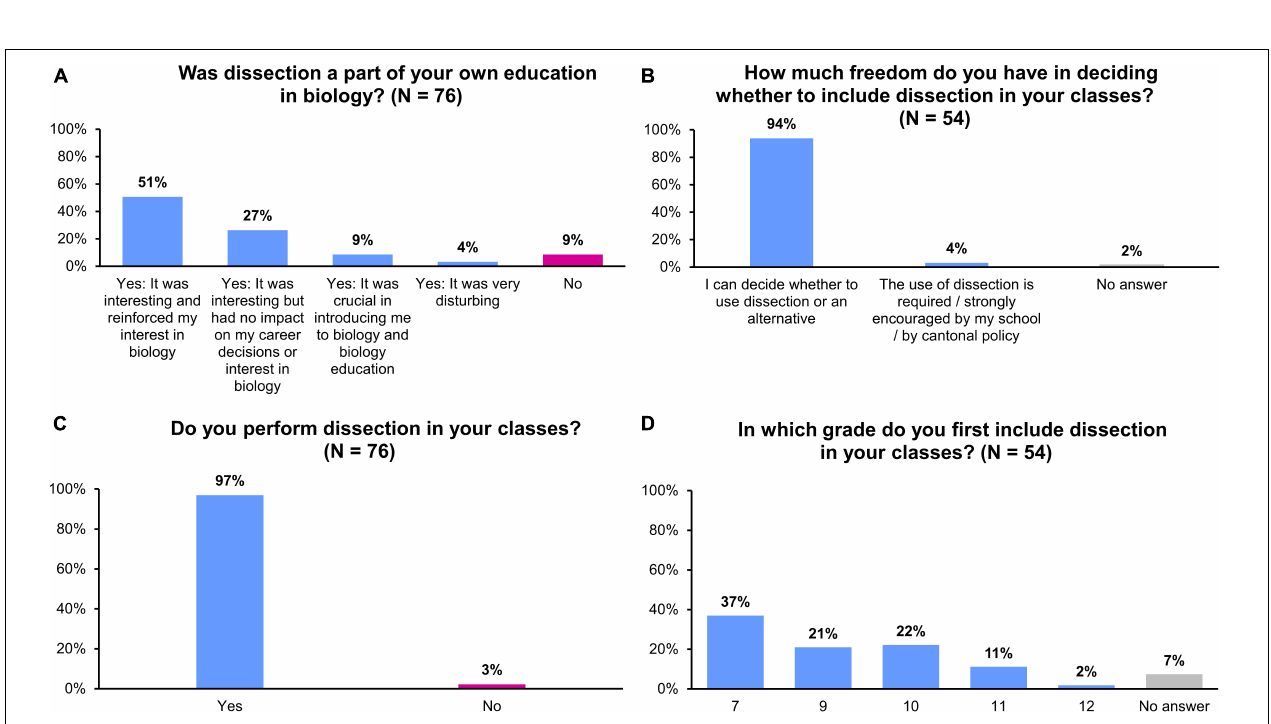
FIGURE 2 | (A) Experience with dissection in respondents’ own education. (B) Extent to which the respondents can decide whether to include dissection in their teaching. (C) Use of animal dissection in biology classes. (D) School grade in which the respondents first include dissection in their